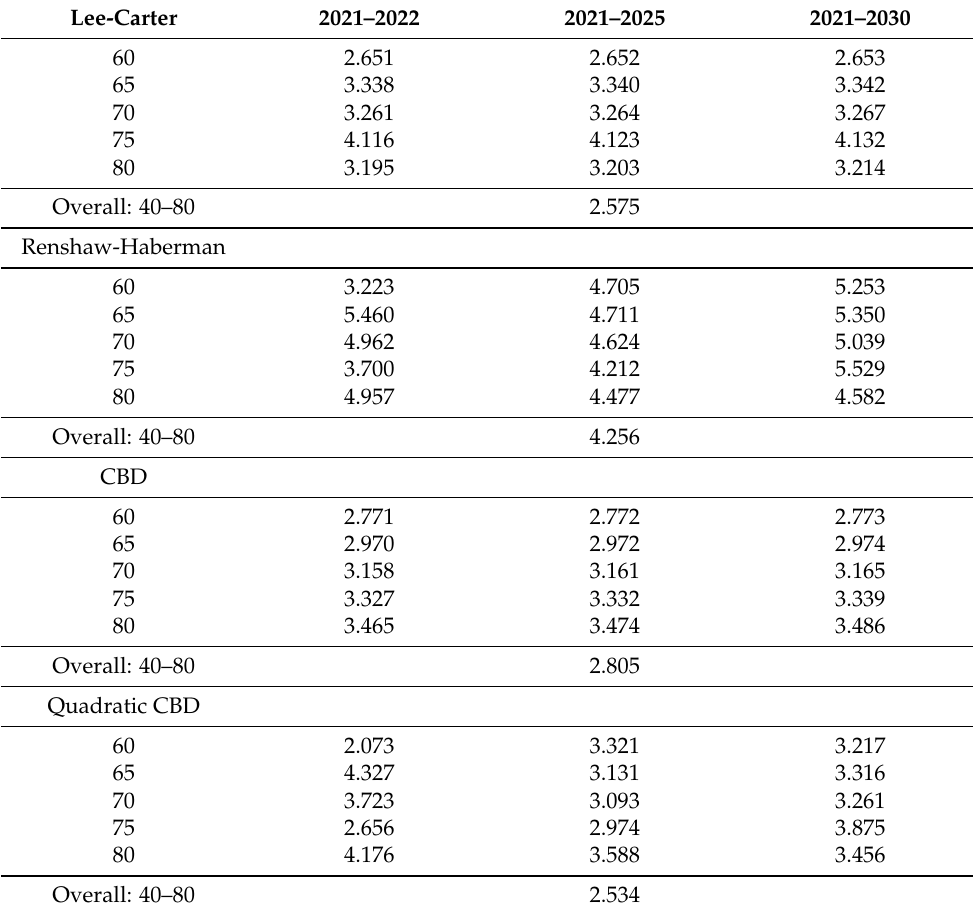
Table 4. Forecasted Mortality Improvement in 2, 5 and 10 Years from 2020 within Pension Ages.